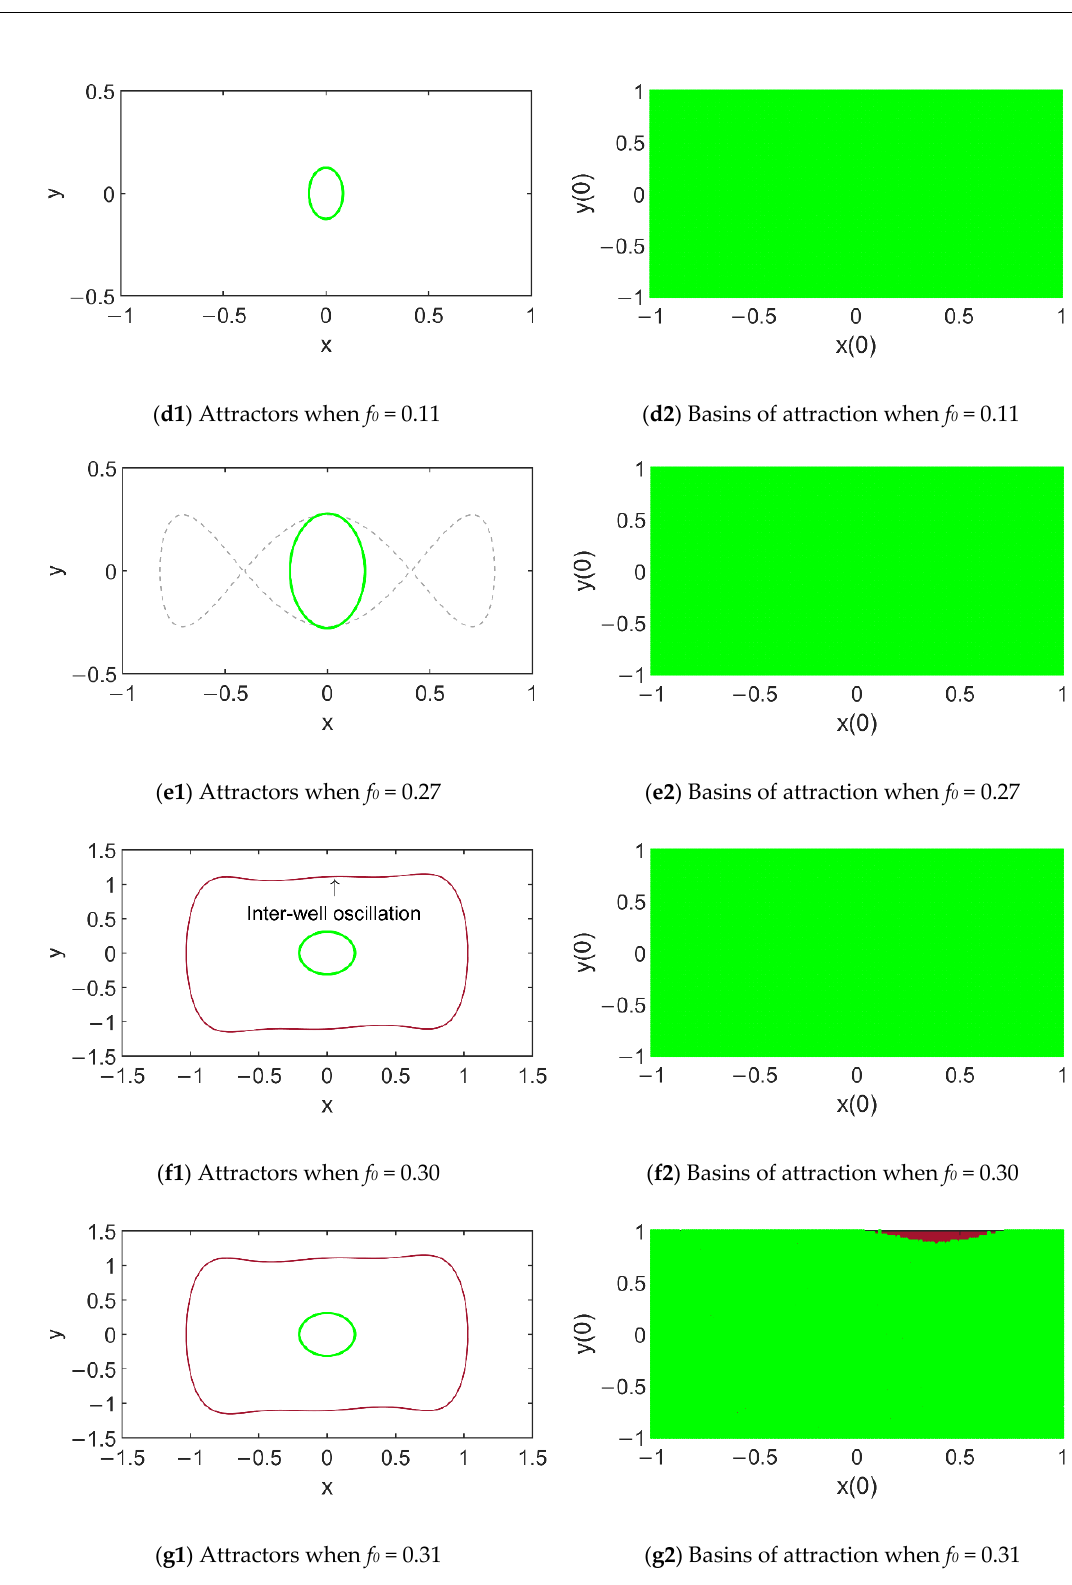
Figure 8. Sequences of attractors and their basins of attraction for f 0 ranging from 0.089 to 0.31. When f 0 continues to increase, the intra-well attractor around O(0, 0) will be enlarged,